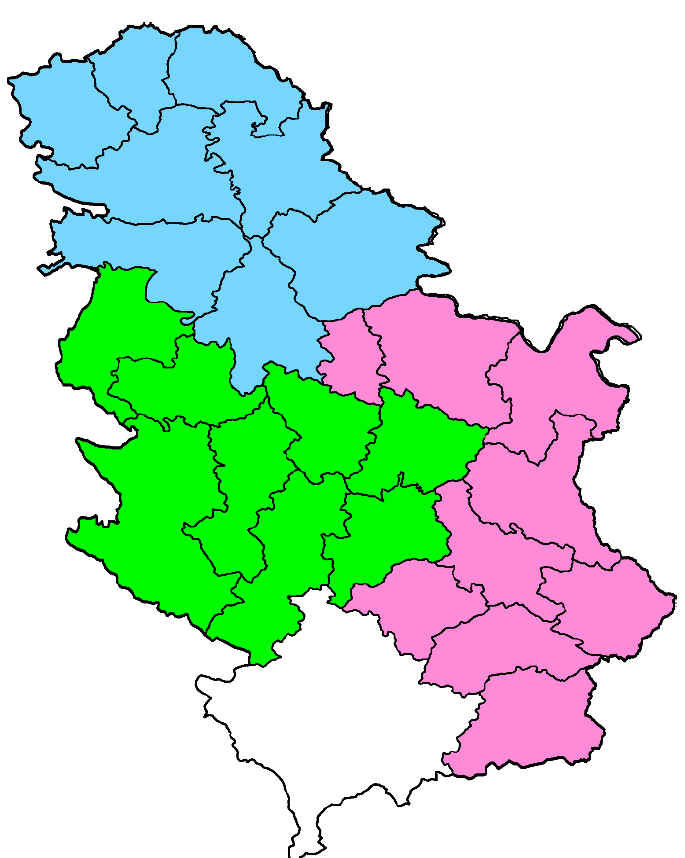
Figure A1. Map of statistical regions as used in Table A1: Northern region — blue; Central and Western region — green; Southern and Eastern region — pink.